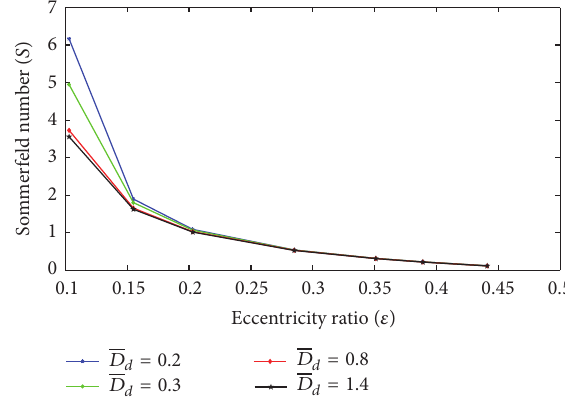
Figure 17: Effect of dam depth ratio on Sommerfeld number.